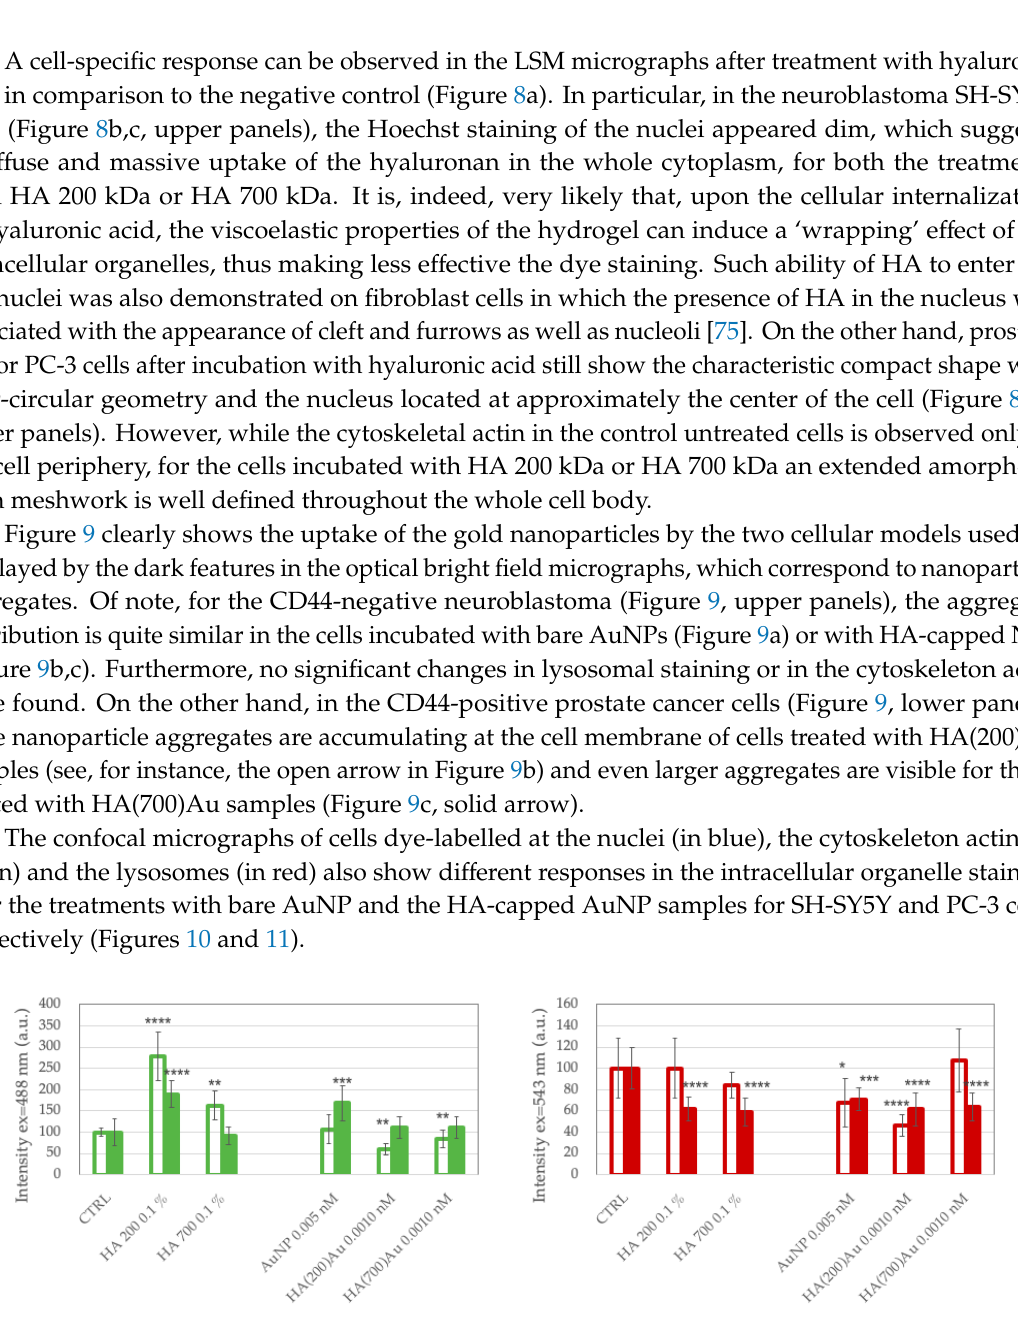
Figure 11. Analysis of emission intensity for cytoskeleton actin ( a ) and lysosomal ( b ) staining of CD44-negative SH-SY5Y (open bars) and CD44-positive PC-3 (solid bars) tumor cells. Cellular treatments were carried out for 90 min with ( a ) AuNP (0.005 nM = 5.5 × 10 2 NP / mL); ( b ) HA(200)Au (0.0010 nM = 7.2 NP / mL, 0.1% w / v HA); ( c ) HA(700)Au (0.0011 nM = 2.5 × 10 1 NP / mL, 0.1% w / v HA). (*) = p < 0.05, (**) = p < 0.01, (***) = p < 0.001, (****) = p < 0.0001 vs CTRL (one-way ANOVA). Average values ± S.E.M. from randomly chosen areas of micrographs from experiments repeated in